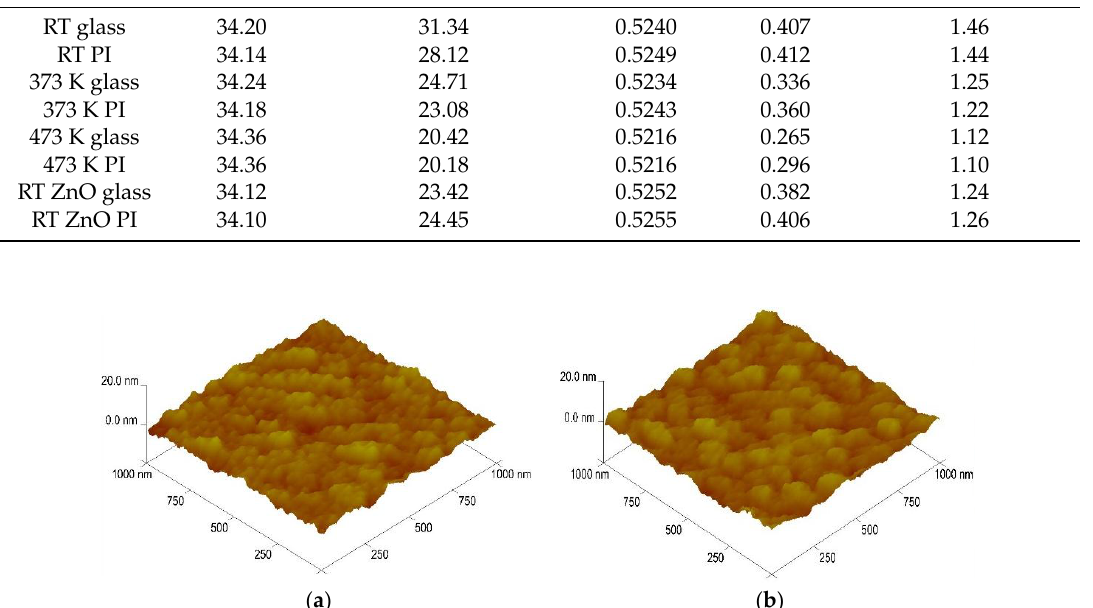
Figure 1. Surface morphologies of the Ga 2 O 3 -doped ZnO (GZO) thin films as a function of substrate and deposition temperature. ( a ) Glass; ( b ) polyimide (PI); ( c ) 373 K-Glass; ( d ) 373 K-PI; ( e ) 473 K-Glass; and ( f ) 473 K-PI, respectively. Table 1. The 2θ value of the (002) peak, crystallite size ( D ), lattice constant (c), the full width at half-maximum (FWHM) value, and roughness of the Ga 2 O 3 -doped ZnO (GZO) thin films deposited on different substrates and at different temperatures and ZnO deposited on different substrates. RT: room temperature; PI: polyimide.